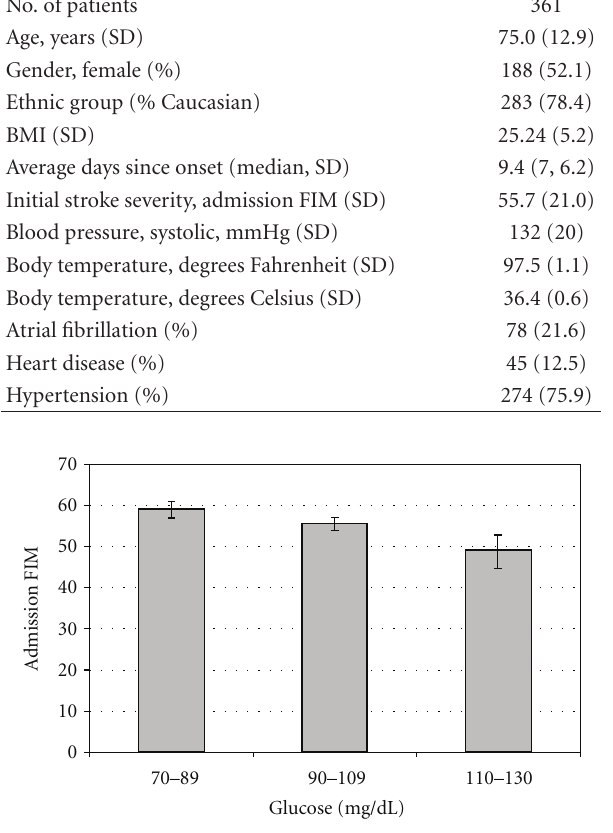
Figure 1: Admission FIM scores versus fasting glucose concen- tration. Lower admission FIM scores correspond to more severe strokes. Error bars are standard errors. The Mann-Whitney P value for the di ff erence between lowest and highest glucose groups is 0.002. The P value for the slope of the glucose-admission FIM re- gression line is 0.003.